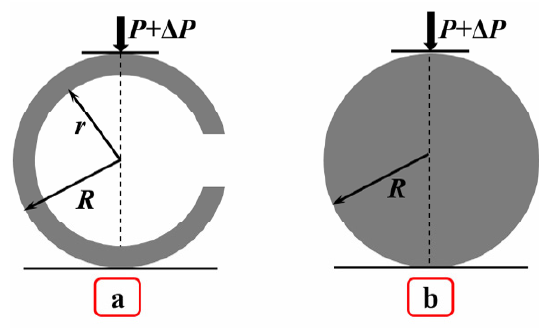
Fig. 6 Schematic diagram of (a) the split ring and (b) the rigid reference